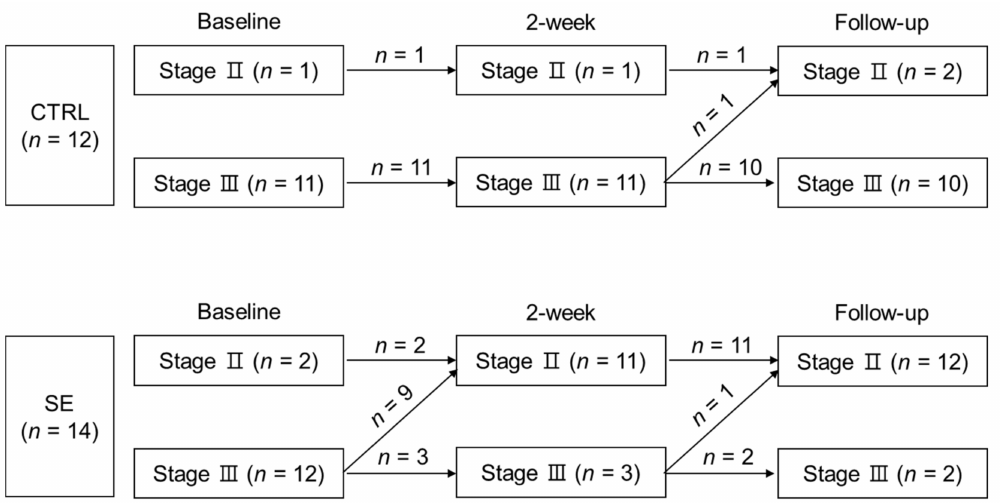
Figure 3. Changes in lymphedema stage during the study. Numbers in parentheses represent the number of participants at each stage. Numbers on the arrows indicate the number of participants who moved according to the direction of the